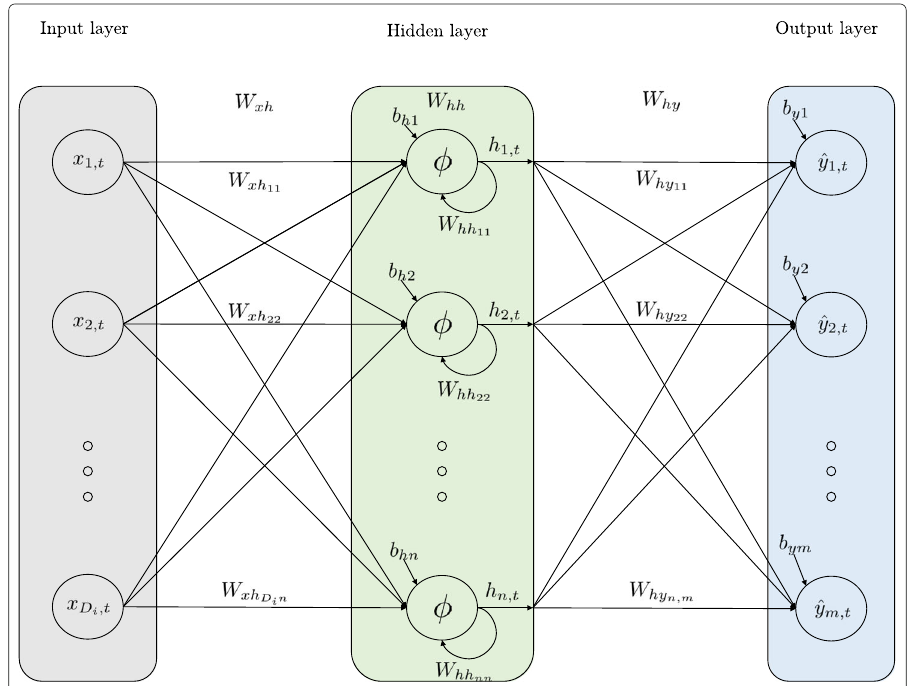
Fig. 6 Architecture of a RNN with an input, a hidden, and an output layer. The network maps the input to a hidden sequence h n , t and to a sequence of outputs y m , t . The parameters D i , n , and m are sequence x D i , t the number of signals, the number of hidden units, and the number of outputs, respectively. W xh , W hh ,